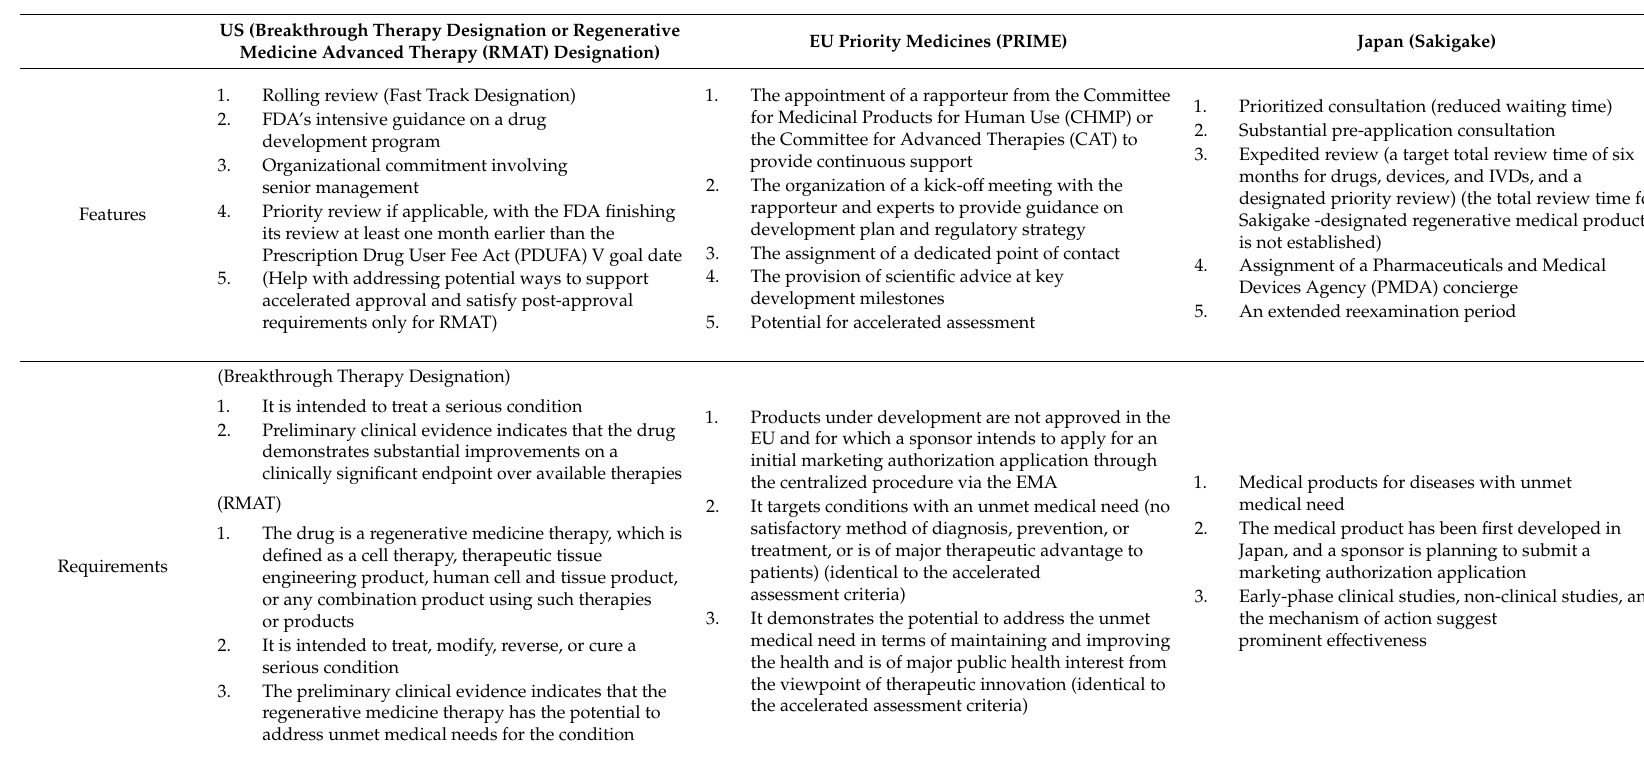
Table 7. Breakthrough therapy